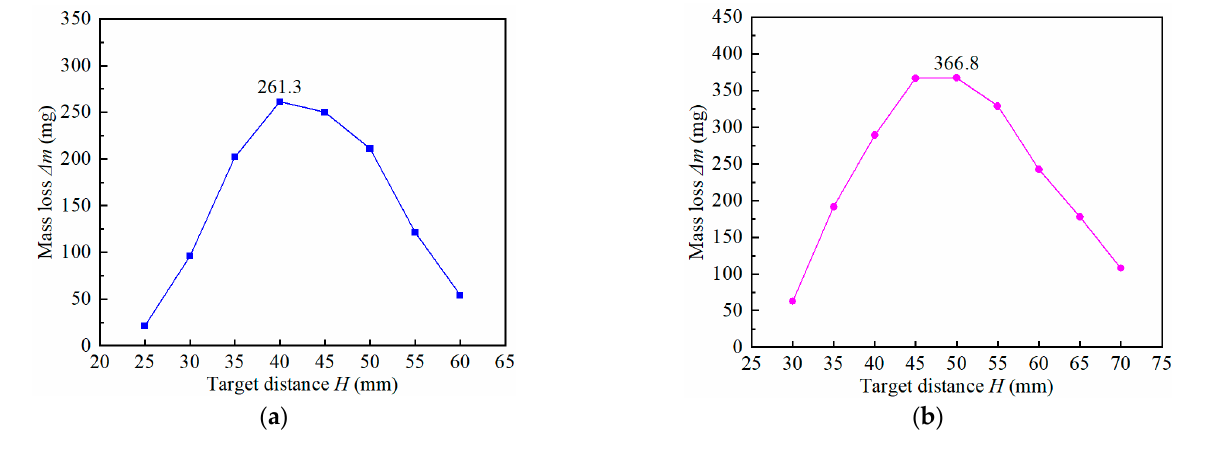
Figure 9. Mass loss of the sample: ( a ) at a working pressure of 10 MPa; ( b ) at a working pressure of 15 MPa.